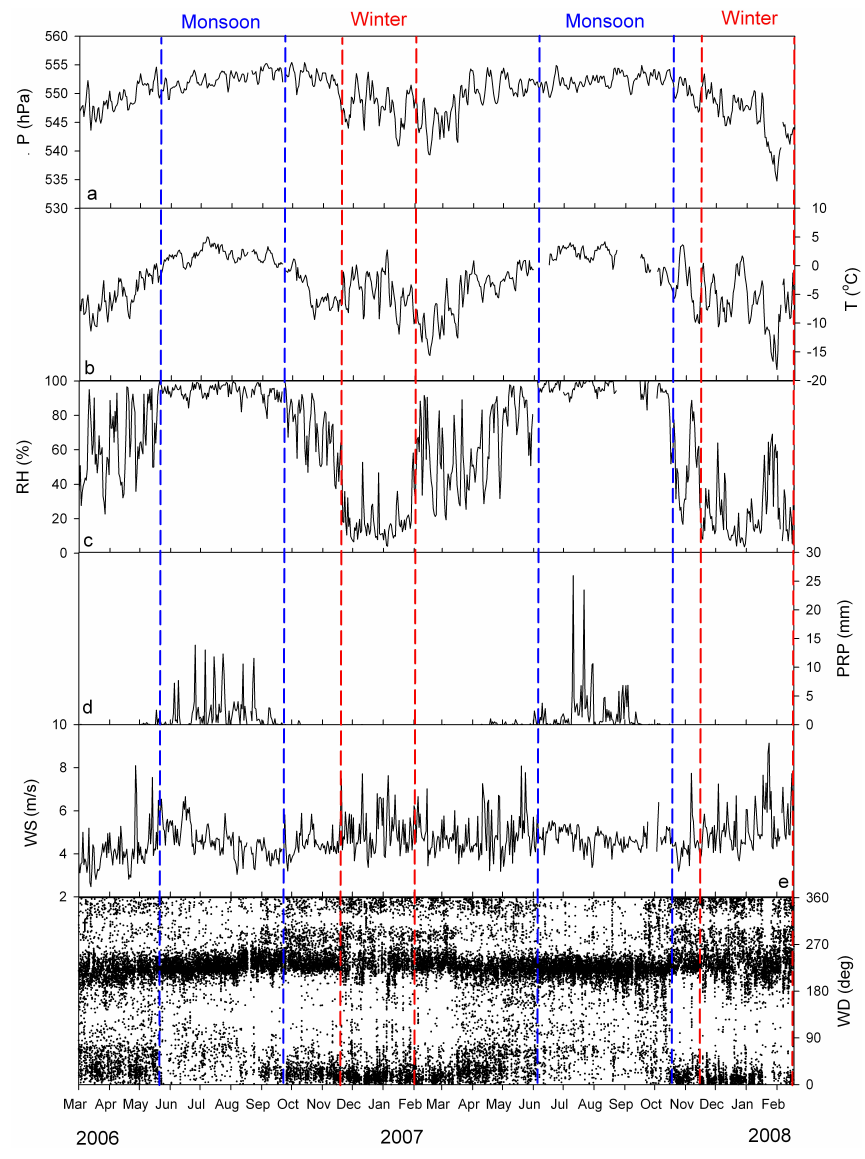
Fig. 2. Behaviour of atmospheric pressure (a) , temperature (b) , relative humidity (c) , rain precipitation (d) , wind speed (e) and wind direction (f) at NCO-P from 1 March 2006 to 28 February 2008. Monsoon (blue) and winter (red) season onset and offset dates are represented by vertical